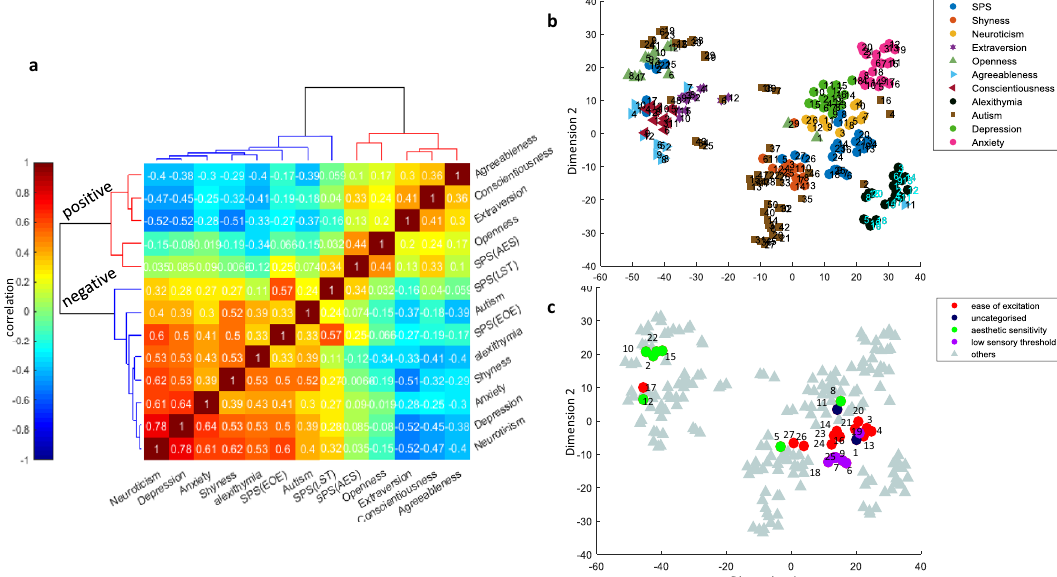
Figure 3. Localization of HSPS questions and its subdomains in the trait space. ( a ) Color-coded pairwise correlation matrix of 10 traits with the three subdomains of SPS sorted by unsupervised HC. ( b ) 2D embedding of all 210 questions across all 11 trait questionnaires using t-SNE. Questions belonging to each trait are shown with different symbols and colors. ( c ) Same as b but separately showing SPS subdomains AES, LST and EOE with other traits grayed